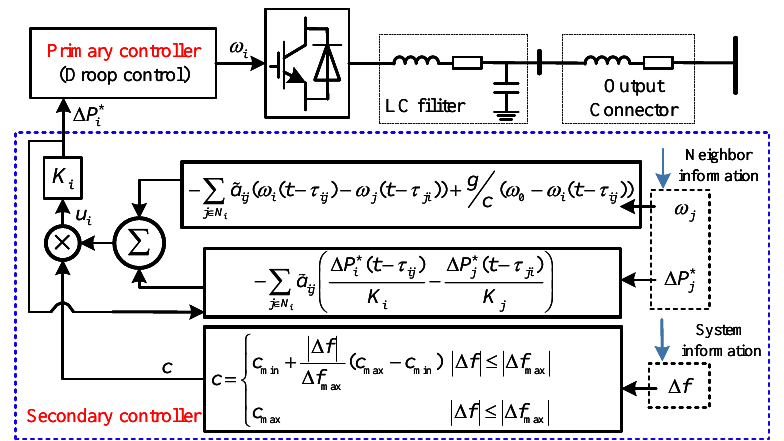
Figure 4. The weight-adaptive frequency controller for an islanded microgrid.